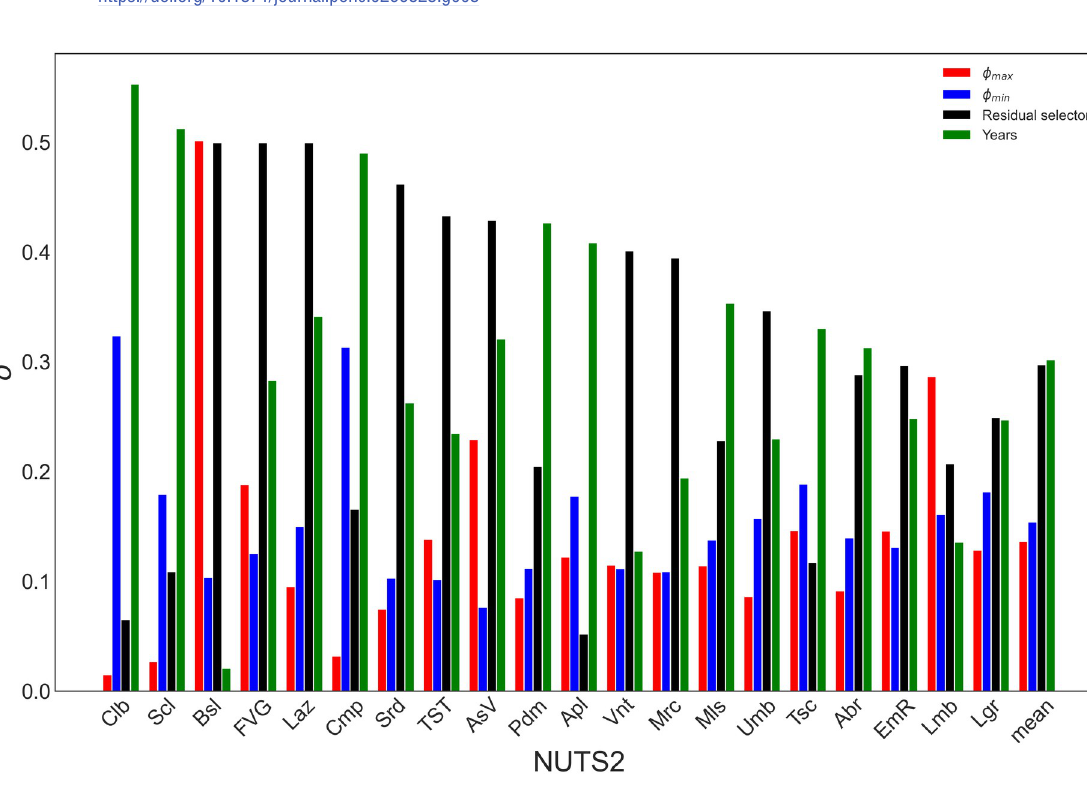
PLOS ONE | https://doi.org/10.1371/journal.pone.0266823 April 22,